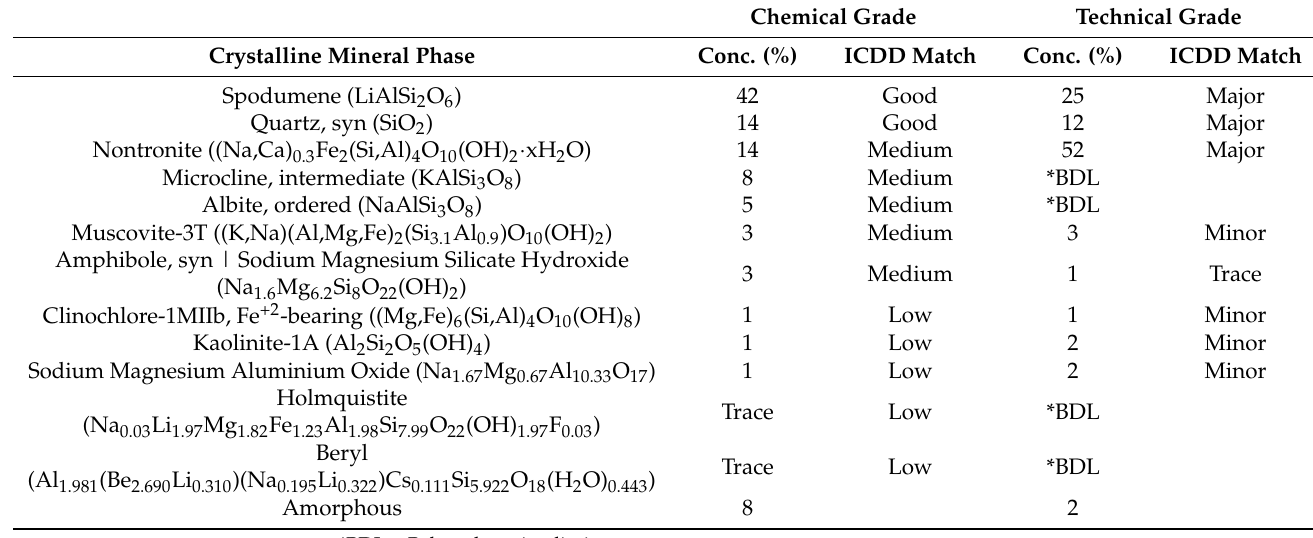
Table 1. Mineralogy, abundance and ICDD match probability of crystalline minerals in chemical and technical grade α -spodumene test samples identified by XRD.